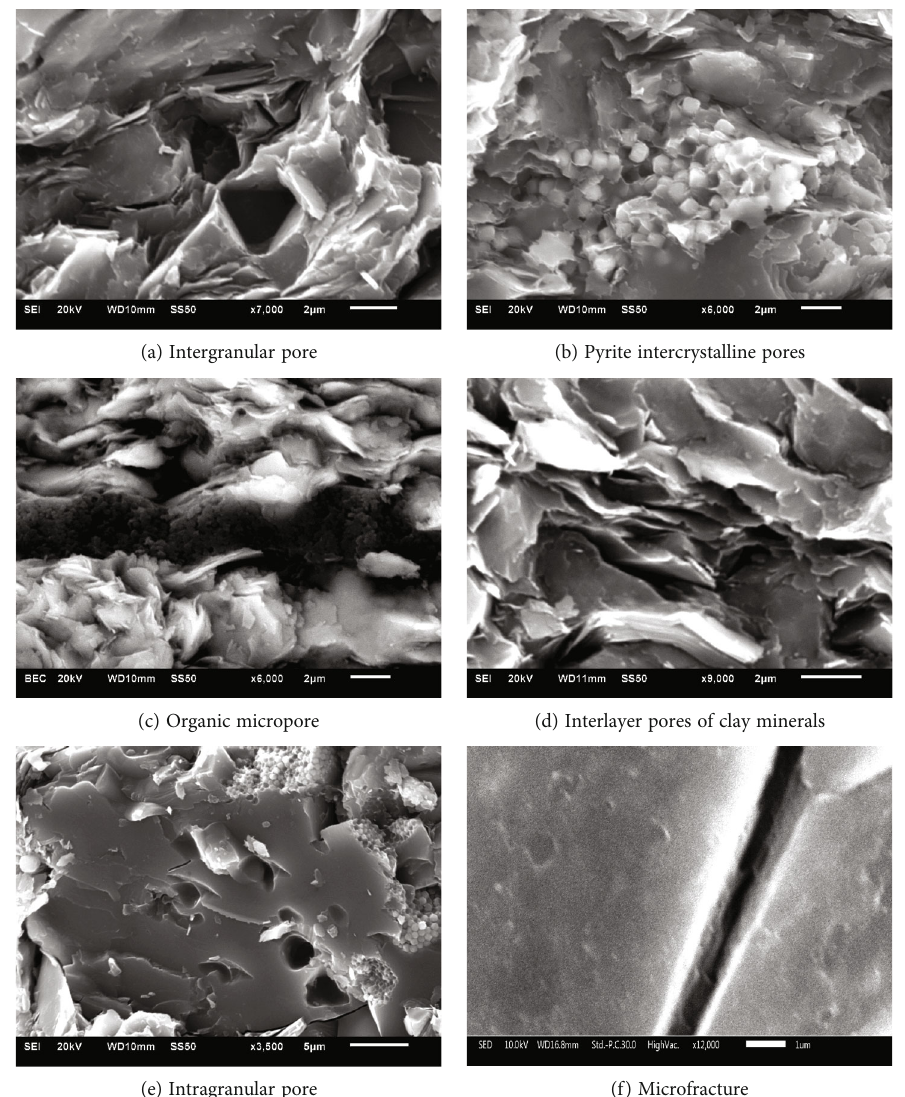
Figure 5: Pore system classi fi cation for WL shale of